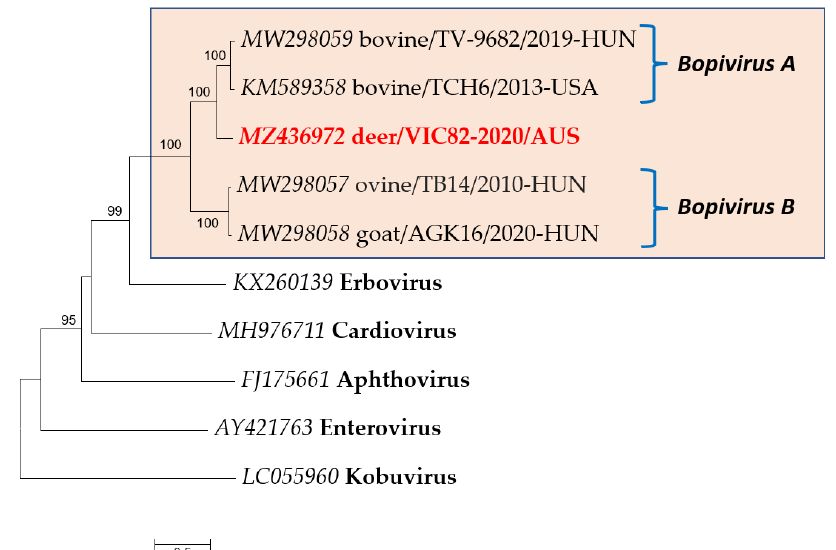
Figure 3. Phylogenetic analysis of deer/bopivirus (in red) and representative member of family Picornaviridae based on complete polyprotein aa sequences. A highlighted box denotes members of the genus Bopivirus . The tree was generated by the maximum-likelihood method based on LG + G substitution model with 1000 bootstrap replicates, and the statistics values > 70% are displayed above the tree branches. The scale bar indicates amino acid substitutions per site.